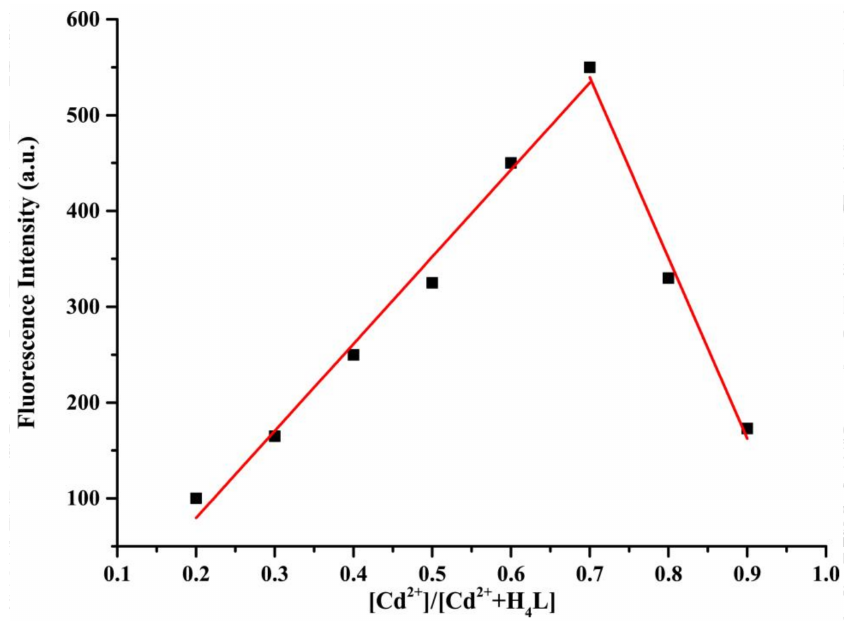
Figure 6. The job’s plot examined between Cd 2+ and H 4 L, indicating the 3:1 stoichiometry, which was carried out by fluorescence spectra ( λ ex = 323